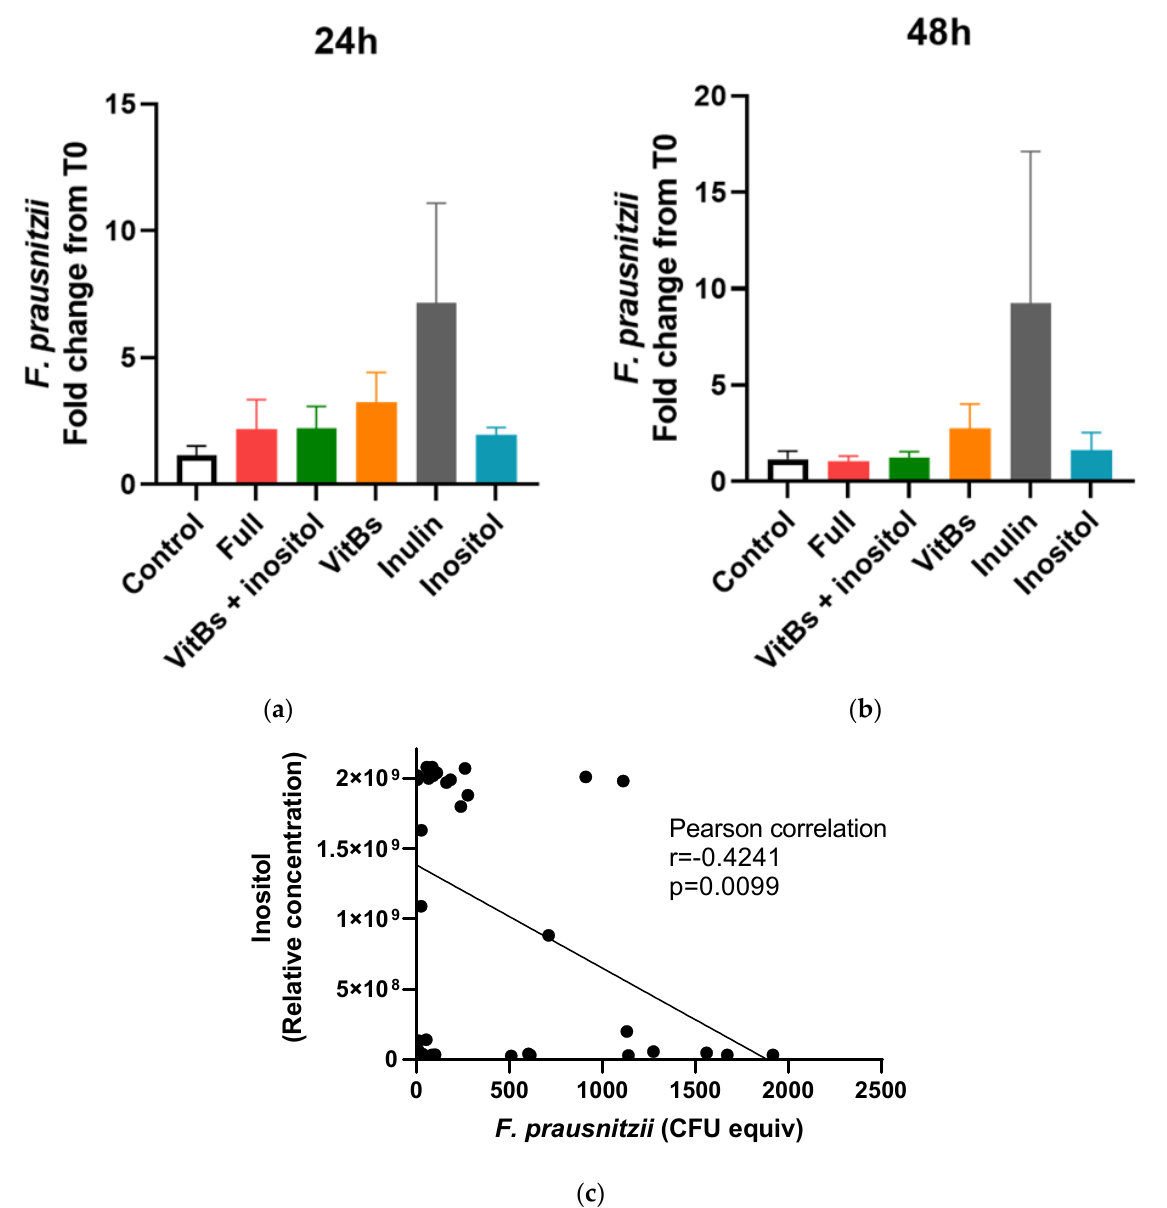
Figure 4. Evaluation of nutrients and nutrient combinations on the growth of F. prausnitzii in a mixed community. Details of in vitro fermentation experiments are described in Methods and Materials. The fold changes in F. prausnitzii at 24 h ( a ) and 48 h ( b ) from the baseline were calculated from results of F. prausnitzii- specific qPCR quantification. Each treatment was tested in 4 fecal samples and data are shown in mean ± SEM. Statistical analysis was performed with ANOVA followed by Tukey post hoc analysis, but no statistically significant difference was found. Relationship between inositol and the amount of F. prausnitzii is shown in ( c ). Signals of butyrate were extracted from 1 H-NMR metabolomics as expressed as relative concentration and the amount of F. prausnitzii was determined with qPCR technique shown as CFU equivalent (equiv). Data were pooled from the groups with added inositol at 6, 24, and 48 h time points. Each ( • ) corresponds to a sample taken from the in vitro fermentation experiment. Pearson correlation analysis indicates a positive relationship between the number of F. prausnitzii and butyrate ( p = 0.0099, r = 0.4241).